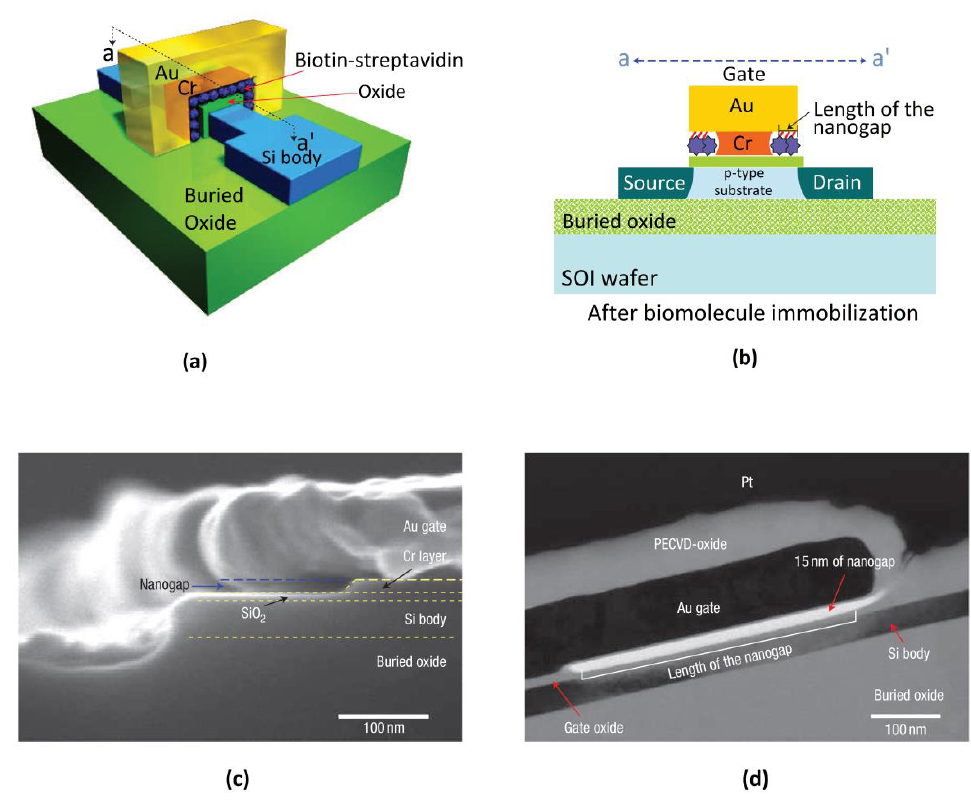
Figure 11. Schematic sketch of the ( a ) 3D structure; ( b ) 2D structure of DMFET exhibiting the air gap that can be filled by biomolecules; ( c ) SEM image and ( d ) TEM image of the nanogap cavity in the DMFET. Reprinted with permission from [40], Copyright 2007 Springer Nature.